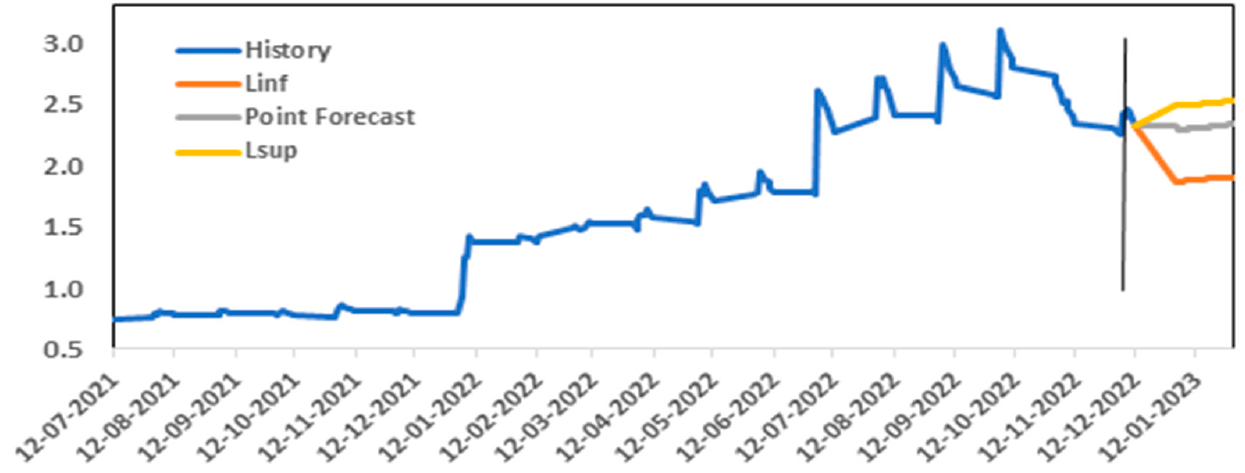
Figure 5. Out-of-Sample Forecast: Scenario 2, Volatility: Nickel/ Confidence Intervals 95% (where Linf and Lsup are lower and upper confidence limits).